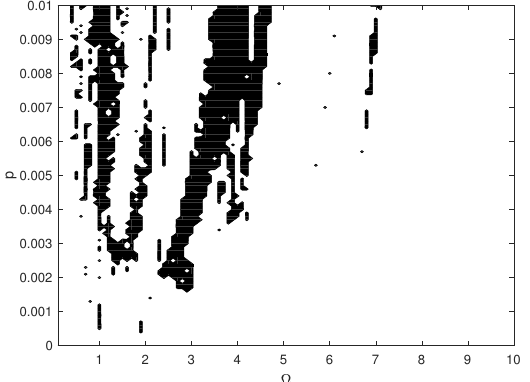
Figure 18. Map of the positive maximal Lyapunov exponent for the pathological ear versus excitation frequency ( Ω ) and amplitude ( p